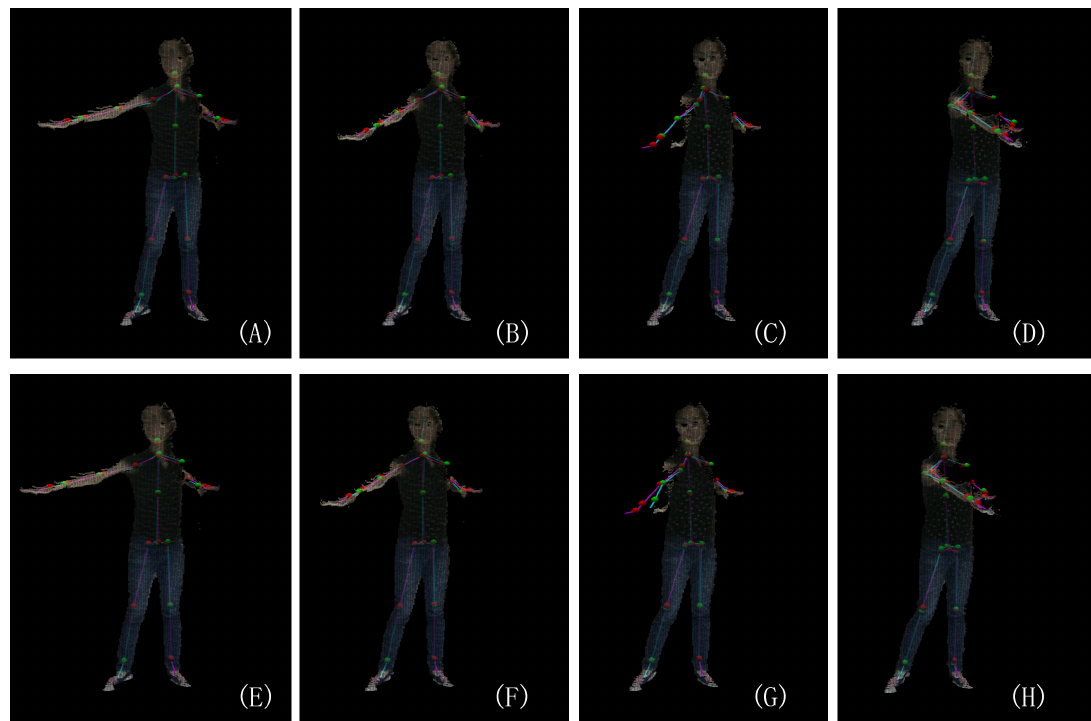
Figure 18. The same four frames of a motion clip are shown: ( A – D ) A comparison between the initial skeleton observed by the Kinect SDK [1] (Magenta) and the updated result with forward prediction (Cyan) and ( E – H ) a comparison between the initial skeleton observed by the Kinect SDK [1] (Magenta) the updated result with both forward and backward prediction